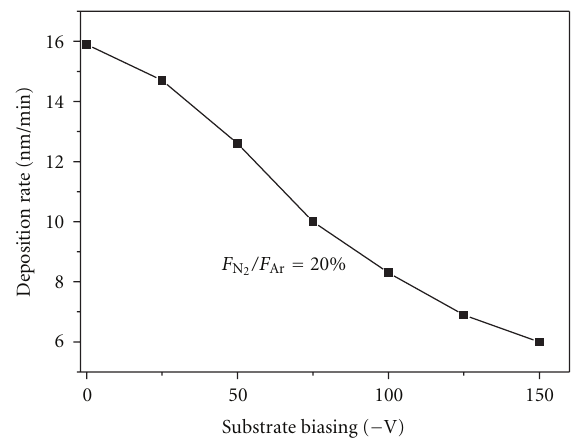
Figure 3: Deposition rate of Nb-N coating versus substrate biasing /F = 20%). ( F N Ar 2